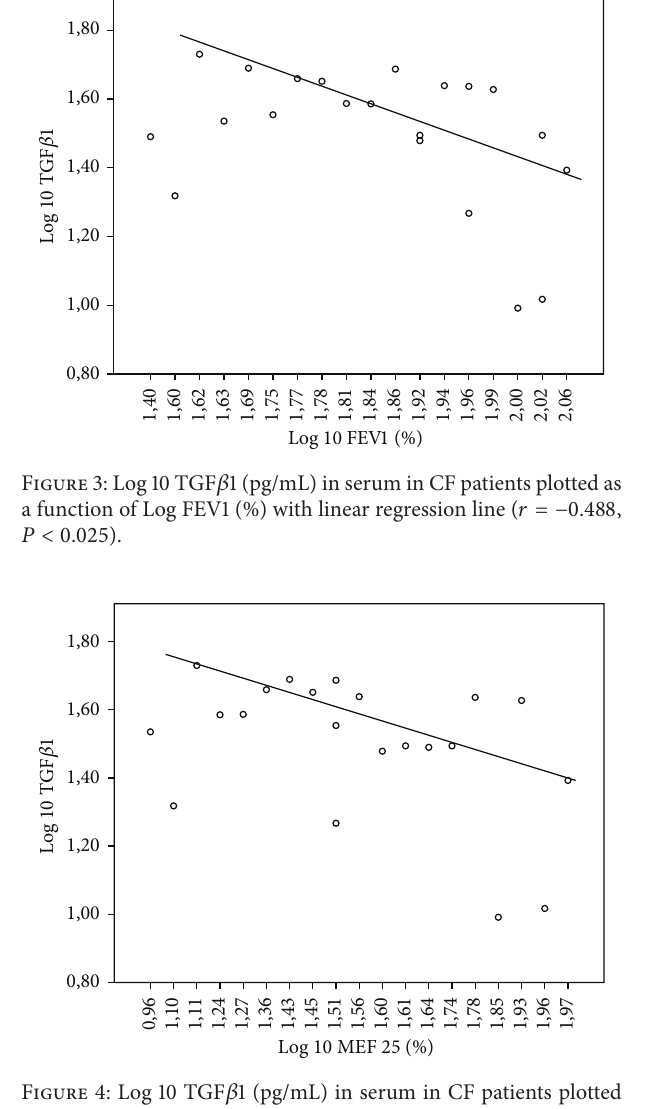
Figure 4: Log 10 TGF 𝛽 1 (pg/mL) in serum in CF patients plotted as a function of Log 10 MEF 25 (%) with linear regression line ( 𝑟 = −0.425 , 𝑃 < 0.055 ).